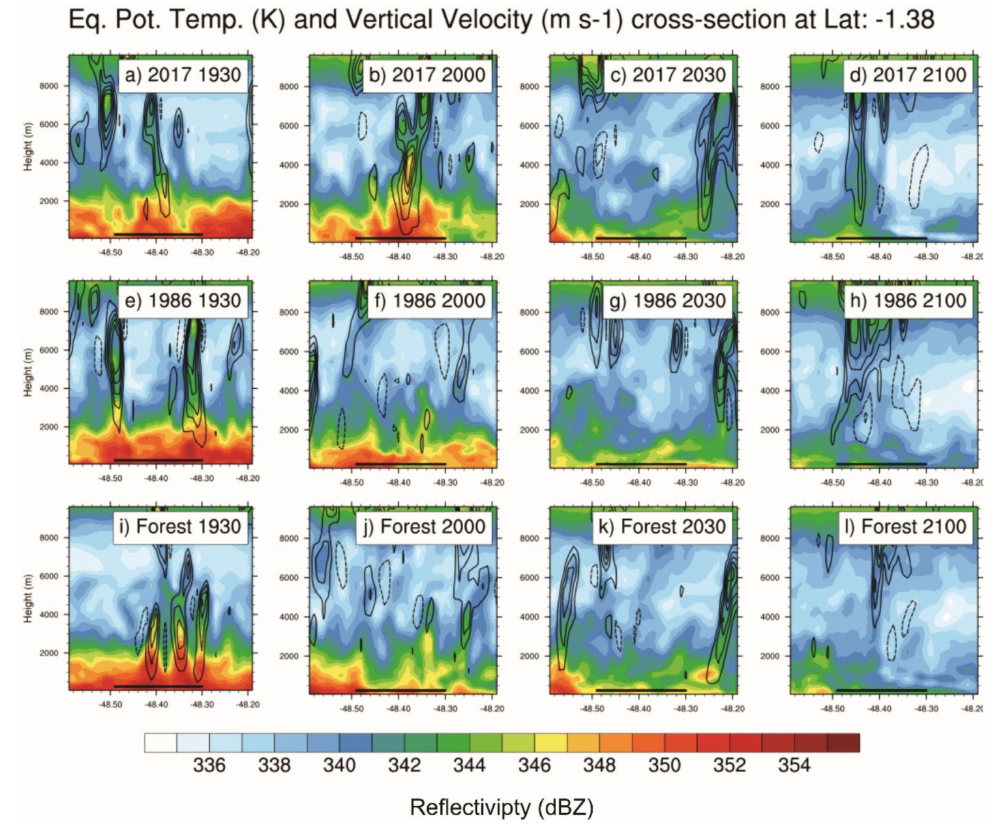
Figure 14. Equivalent potential temperatures (K) for the 2017 ( a – d ), 1986 ( e – h ), and forest ( i – l ) scenarios at 1930, 2000, 2030, and 2100 UTC. The dashed contours are the negative vertical wind speed, and the solid contours are the positive vertical wind velocity, ranging from − 5 to 5 m s − 1 and an increment of 1 m s − 1 . The black line near the x -axis represents the